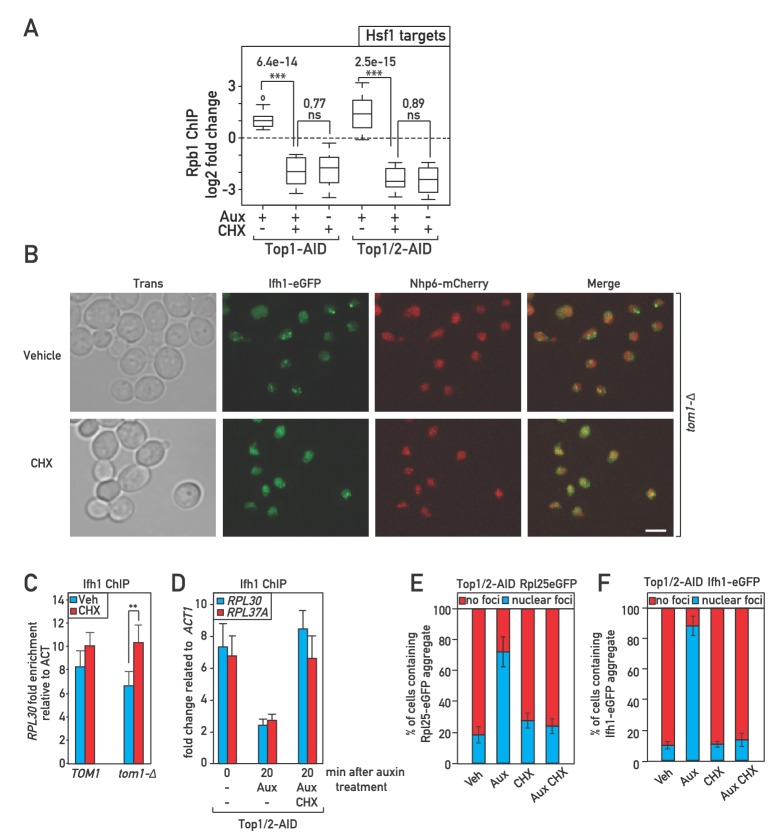
Characterization of Ifh1-FRB Top1-AID Top2-AID and Ifh1-FRB Top1-AID strains; binding of Ifh1 at Hsf1 target and RP gene promoters.(A) Box plots showing RNAPII ChIP-seq fold-change for Hsf1 target genes after auxin (Aux) and/or cycloheximide (CHX) treatment of Top1-AID or Top1/2-AID cells, as indicated. (B) A tom1-Δ strain expressing Ifh1-eGFP and Nhp6-mCherry was grown to mid-exponential phase and cell samples were used for fluorescence microscopy analysis following 20 min of vehicle (top panels) or cycloheximide (CHX; bottom panels) treatment. (C) Ifh1 occupancy at the RPL30 promoter 20 min following cycloheximide (CHX, red) or vehicle (Veh, blue) treatment in wild type (TOM1) or tom1-Δ cells. (D) Ifh1 occupancy at the RPL30 and RPL37A promoters 0 or 20 min following mock or Top1/2-AID depletion (- or Aux) in the presence (CHX) or absence (-) of cycloheximide. (E, F) Numbers of cells where Rpl25-eGFP (E) or Ifh1-eGFP (F) nuclear foci were identified, presented as a percentage. In each experiment 75–100 cells were used for the quantification. Data are reported as averages from two experiments, with standard deviations indicated.